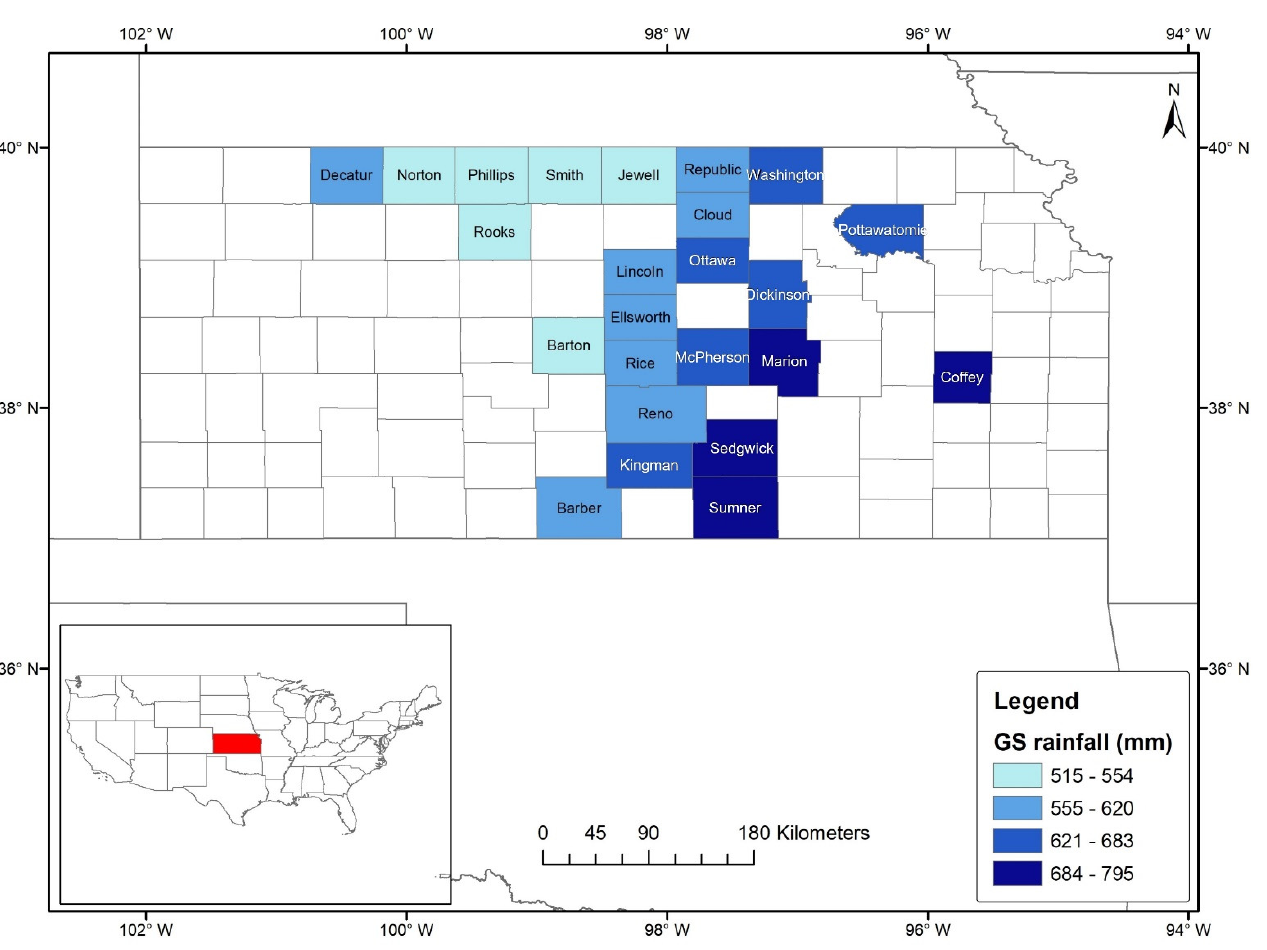
Figure 6. Map of Kansas showing rainfall distribution (in millimeters) during the calculated growing season for each selected county over the period of 30 years (1988 to 2017). The mean growing season maximum temperature was found to be 26.3 ± 0.5 ◦ C and the minimum temperature was 12.4 ± 0.6 ◦ C (Figure 7A). Similarly, the cumulative mean growing season thermal units were estimated to be 3164 ± 200 ◦ C-day for the rainfed counties. Barber, Kingman, and Rooks Counties had the highest growing season cumulative thermal units (above 3400 ◦ C-day) among the selected counties (Figure 7B).